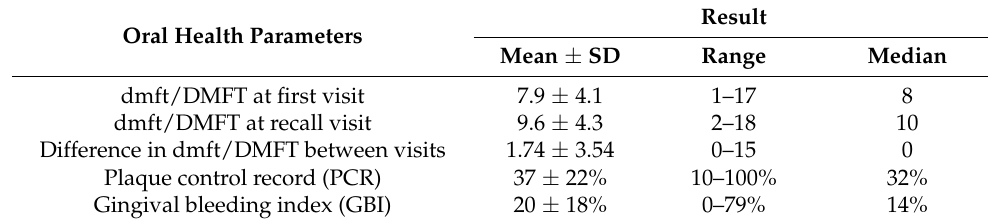
Table 2. Oral health parameters for the participants.